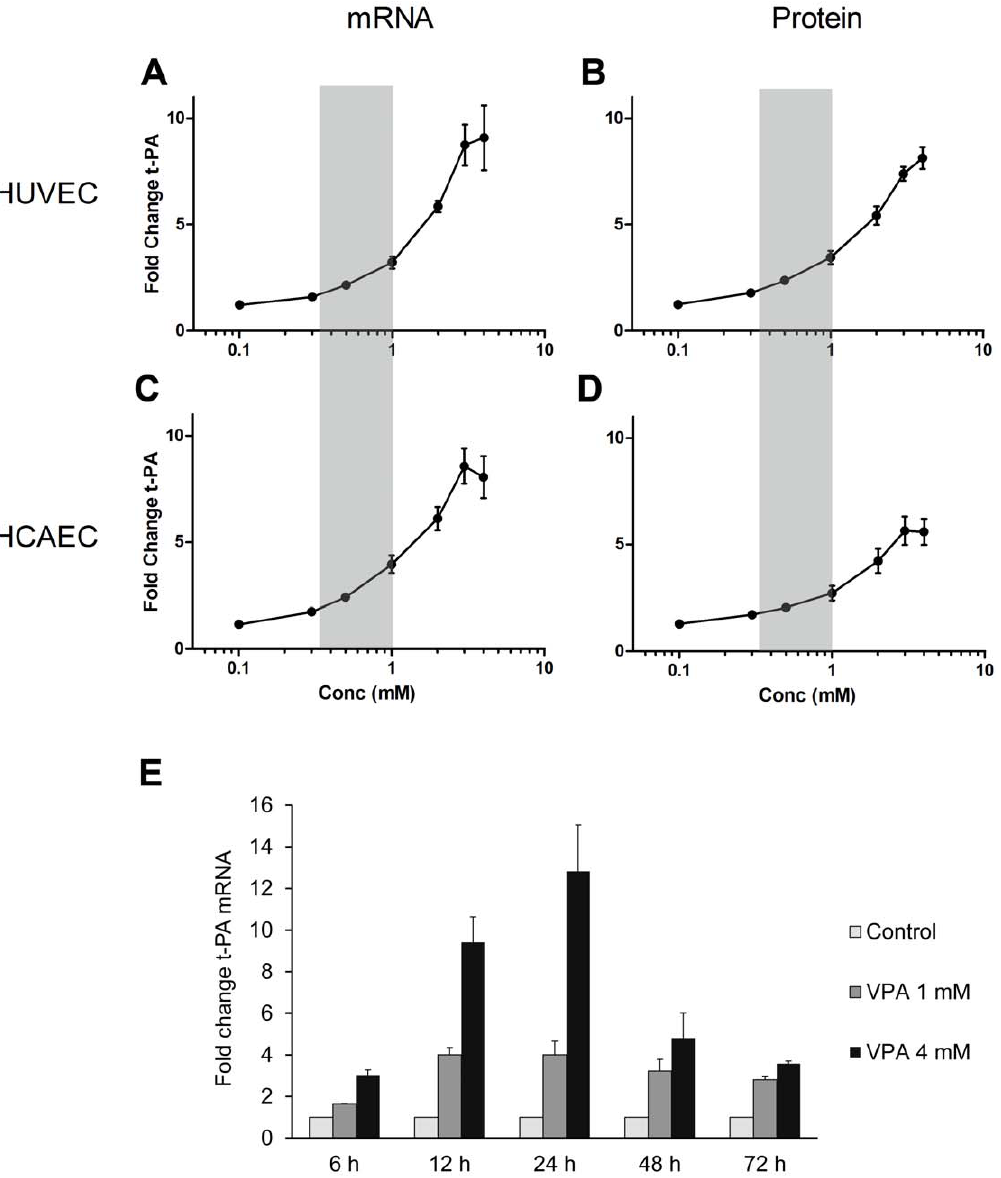
Figure 1. Effects of valproic acid (VPA) on mRNA and protein expression in HUVEC and HCAEC. HUVEC ( A and B ) and HCAEC ( C and D ) were exposed to different concentrations (0.1–4 mM) of VPA for 24 h. mRNA ( A and C ) was quantified with real-time PCR and secreted t-PA protein ( B and D ) in conditioned media by ELISA. Values are expressed as fold change over control cells. The shaded areas show the plasma concentration range of VPA achieved after clinical VPA treatment. E . HUVECs were treated with 1 mM or 4 mM of VPA and t-PA mRNA quantified after 6, 12, 24, 48 and 72 h. The results show mean values 6 SEM of three independent experiments ( n =3) performed in duplicate. For Fig. 1E statistical significance was tested using 2-way ANOVA for repeated measures: p(dose) , 0.01, p(time) , 0.01 and p(dose 6 time) , 0.001.